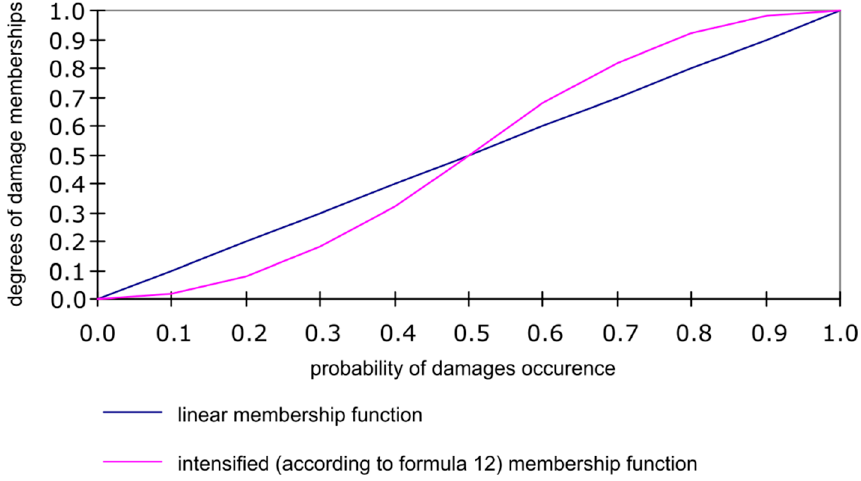
Figure 1. The effect of the contrast intensification of the degrees of damage